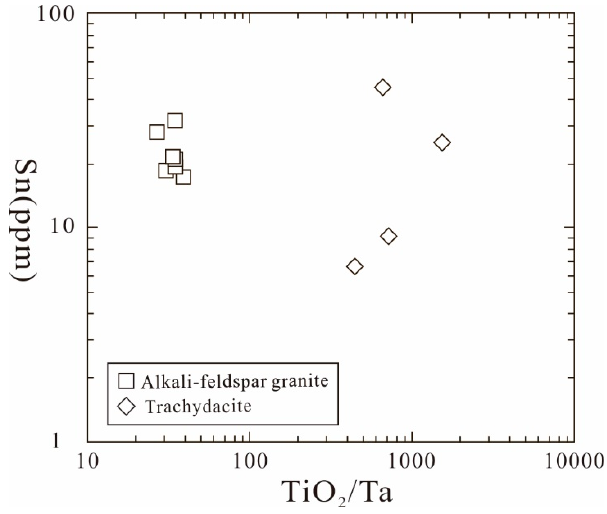
/ Ta vs. Sn diagrams of the Tiantangshan granitic Figure 10. TiO 2 /Ta vs. Sn diagrams of the Tiantangshan granitic rocks. Figure 10. TiO 2